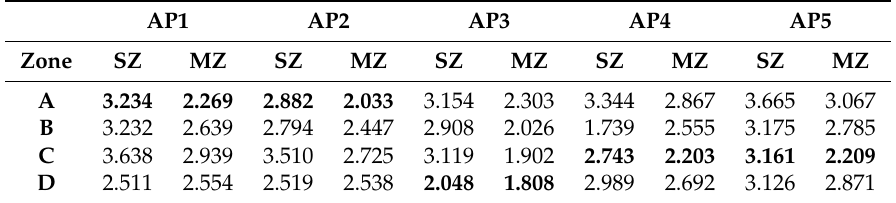
Table 2. Path loss exponent values of Static Zone (SZ) and in-Motion Zone (MZ) representations of all Access Points (AP). Bold-marked values correspond to LOS